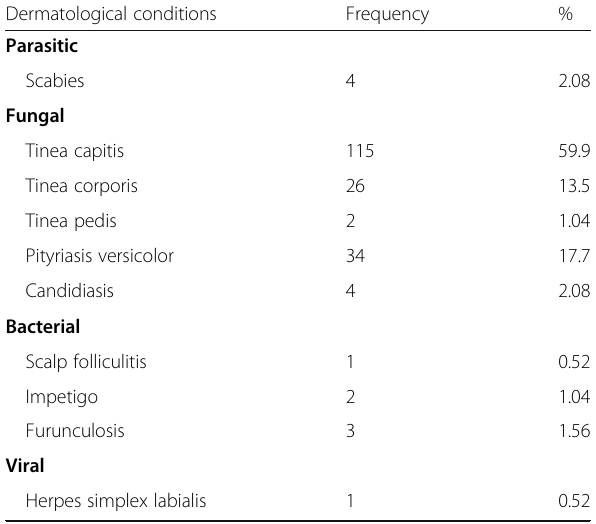
Table 2 Pattern of infectious dermatological conditions among children living in orphanage centres in Dar es Salaam ( n = 192)